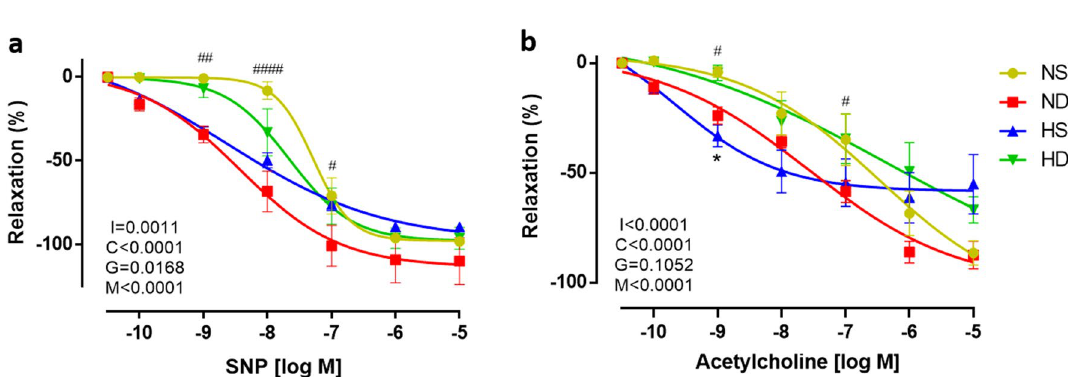
Figure 4. Aorta relaxation 7–10 days after renal denervation. ( a ) Concentration–response curve to sodium nitroprusside; ( b ) Concentration–response curve to Acetylcholine. NS: normotensive sham (n = 6); ND: denervated normotensive (n = 9), HS: SHR sham (n = 5); HD: denervated SHR (n = 4). Data were analyzed by two-way ANOVA followed by Fisher post hoc test. Values are mean ± SEM. ANOVA: Interaction factor (I); Concentration factor (C); Groups factor (G); Matching (M). #p < 0.05; ##p < 0.01; ####p < 0.0001 NS vs. ND; *p < 0.05 HS vs. RDN effects on aortic vasorelaxation response. Figure 4a and b represent aorta relaxation when ves- sel rings were exposed to a concentration–response curve to sodium nitroprusside (endothelium-independent relaxation), and acetylcholine (endothelium-dependent relaxation). When compared to normotensive sham rats (yellow circles), normotensive denervated rats (red squares) exhibited a left-down shift in vasodilator response. This is also observed in half-maximal dose (logED 50 ) which shows a greater sensibility in ND to SNP (Table 1). On the other hand, although renal denervation did not change final relaxation to SNP in the hypertensive group, we observed a right up shift in HD group (green up-side down triangles) at lower concentrations when compared to HS (blue triangles). Also, in both SNP and Ach-induced relaxation the curve shifted to control